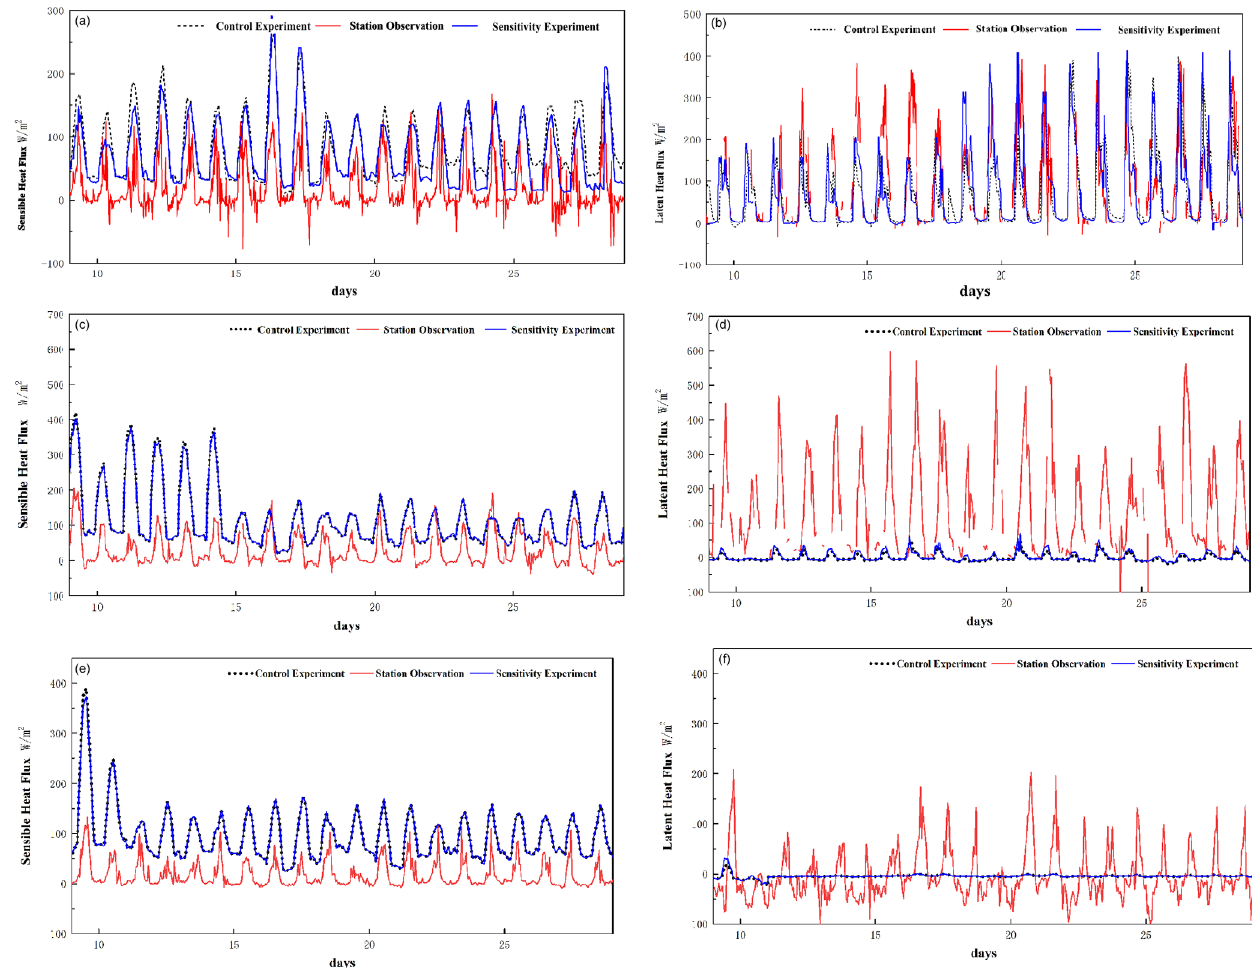
Figure 9. Comparison of simulated and observed sensible heat flux (a, c, e) and latent heat flux (b, d, f) at BJ, NAMC and NPAM